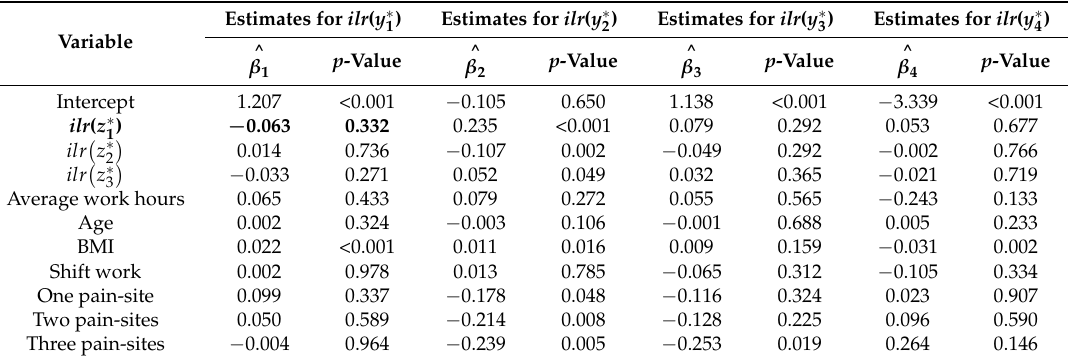
Table A1. Output table for model 1a (among men, N = 400).